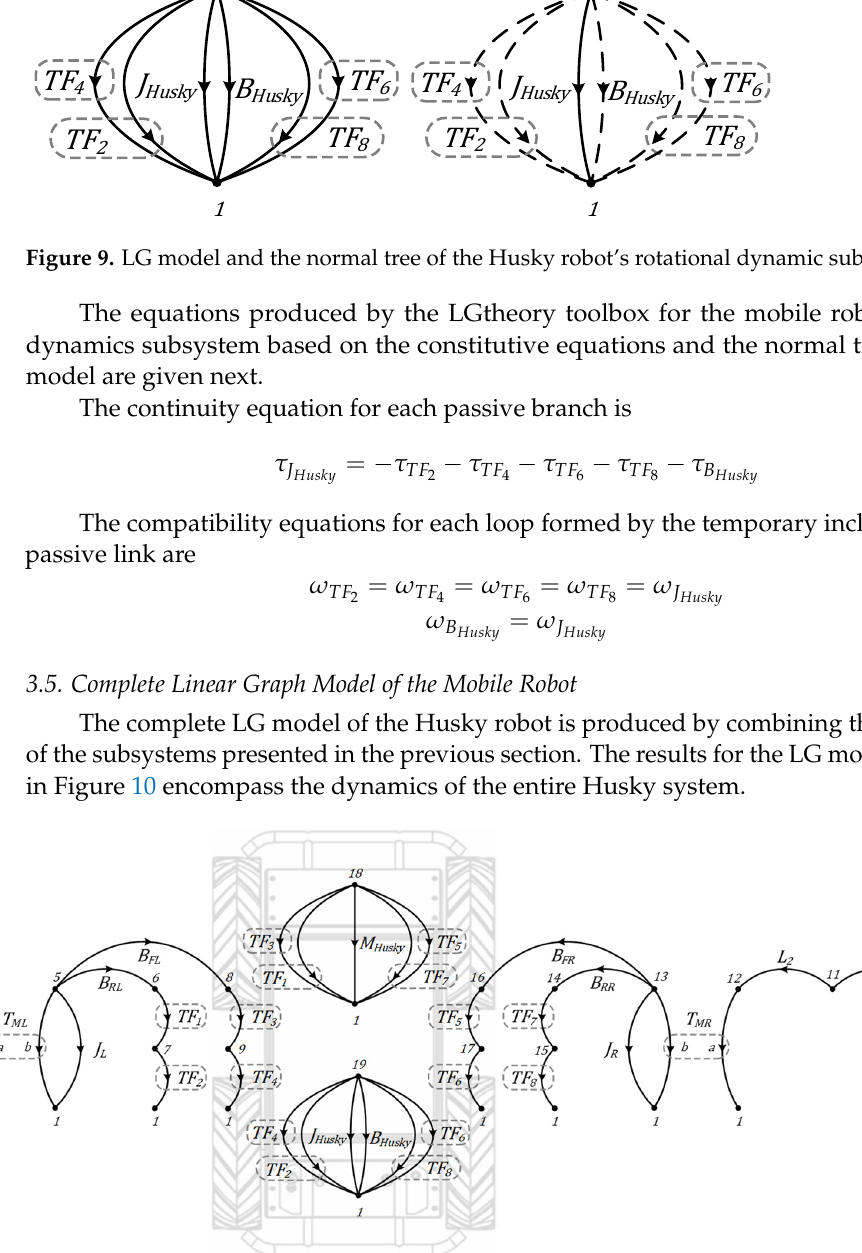
9 of 17 Figure 8. LG model and the normal tree of the Husky robot translational dynamic subsystem. The equations generated by the LGtheory toolbox for the translational dynamic sub- system of the mobile robot based on the constitutive equations and the normal tree of the LG model are as follows. The continuity equation for each passive branch is 𝐹 (cid:3014) (cid:3257)(cid:3296)(cid:3294)(cid:3286)(cid:3300) = −𝐹 (cid:3021)(cid:3007) (cid:3117) − 𝐹 (cid:3021)(cid:3007) (cid:3119) − 𝐹 (cid:3021)(cid:3007) (cid:3121) − 𝐹 (cid:3021)(cid:3007) (cid:3123) (13) The compatibility equations for each loop formed by the temporary inclusion of each passive link are 𝑣 (cid:3021)(cid:3007) (cid:3117) = 𝑣 (cid:3021)(cid:3007) (cid:3119) = 𝑣 (cid:3021)(cid:3007) (cid:3121) = 𝑣 (cid:3021)(cid:3007) (cid:3123) = 𝑣 (cid:3014) (cid:3257)(cid:3296)(cid:3294)(cid:3286)(cid:3300) (14) 3.4. Mobile Robot Rotational Dynamics Subsystem